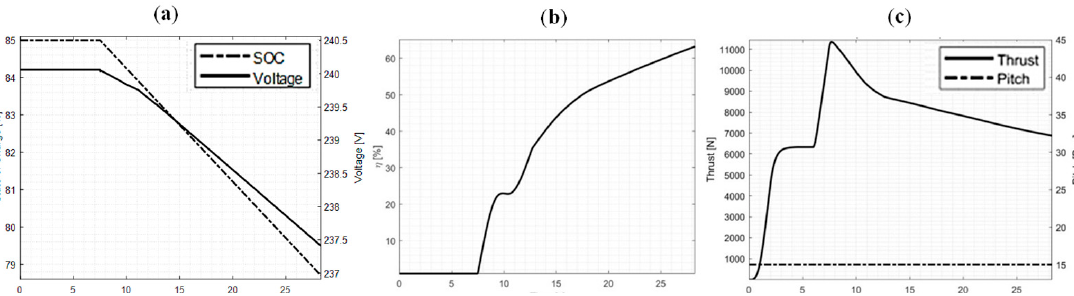
Figure 13. Behavior of significant simulated signals: ( a ) Battery SOC and Voltage ( b ) Propeller efficiency ( c ) Propeller thrust and pitch.